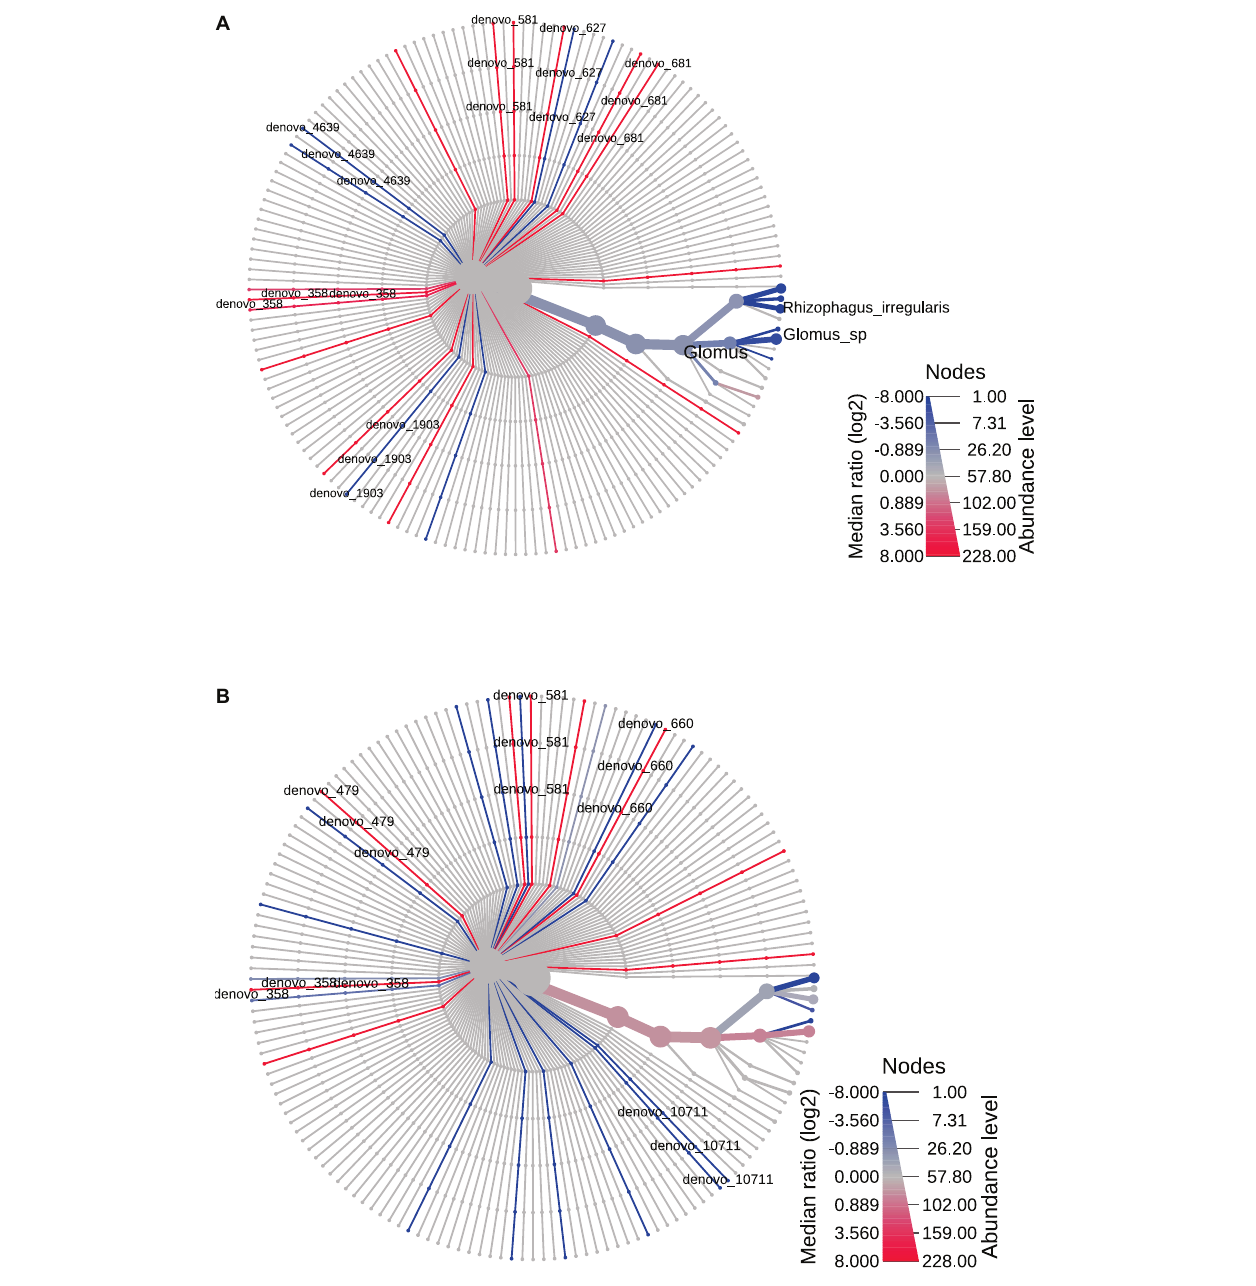
FIGURE 5 | Heat tree based on the factor “space” reporting the effect of the presence of Vitis vinifera roots on the hierarchical structure of taxonomic classifications (median abundance, non-parametric Wilcoxon rank–sum test). (A) Bs1S vs. Rs1S. (B) Bs2S vs. Rs2S. Heat tree analysis was performed using the R metacoder package of MicrobiomeAnalyst, a freely available online software